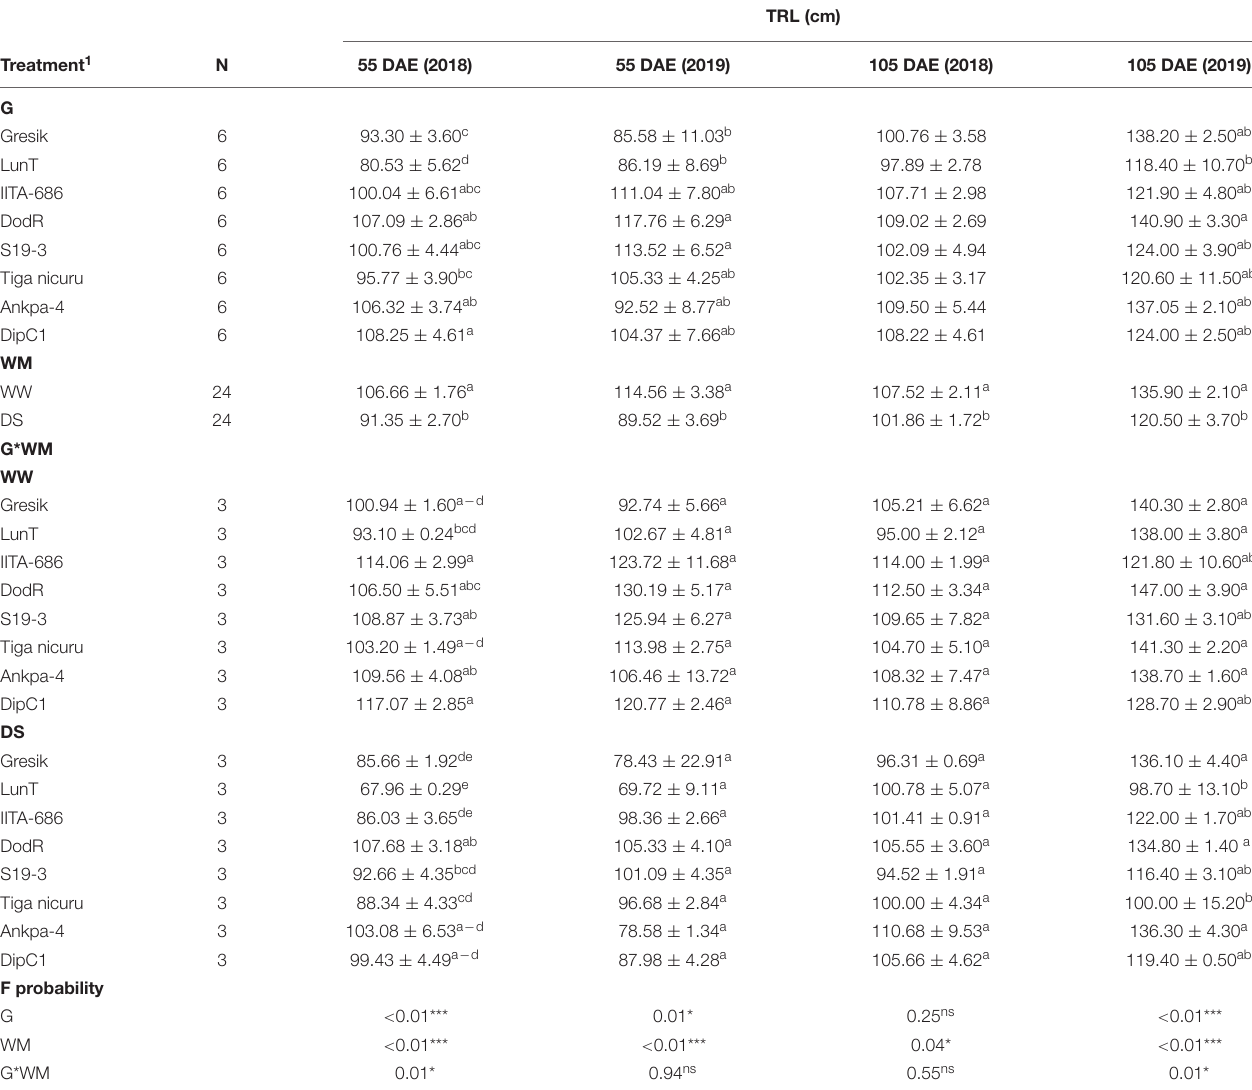
TABLE 3 | Analysis of variance (ANOVA) for tap root length (TRL) at 55 and 105 DAE (50 days of DS recovery) of eight bambara groundnut genotypes, grown in soil-filled PVC columns under a rainout shelter under WW and DS in two seasons 2018 and 2019.